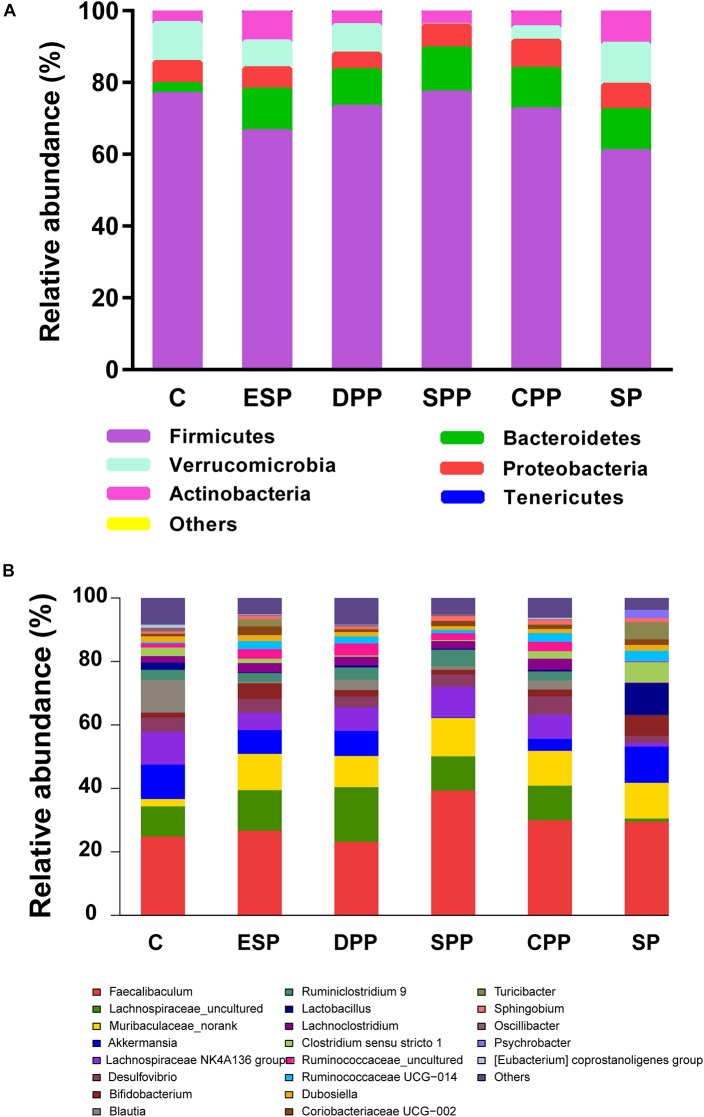
Composition of cecum microbiota. (A) At the phyla levels. (B) At the genera levels. C, casein; CPP, cooked pork protein; DPP, dry-cured pork protein; ESP, emulsion-type sausage protein; SP, soy protein; SPP, stewed pork protein.